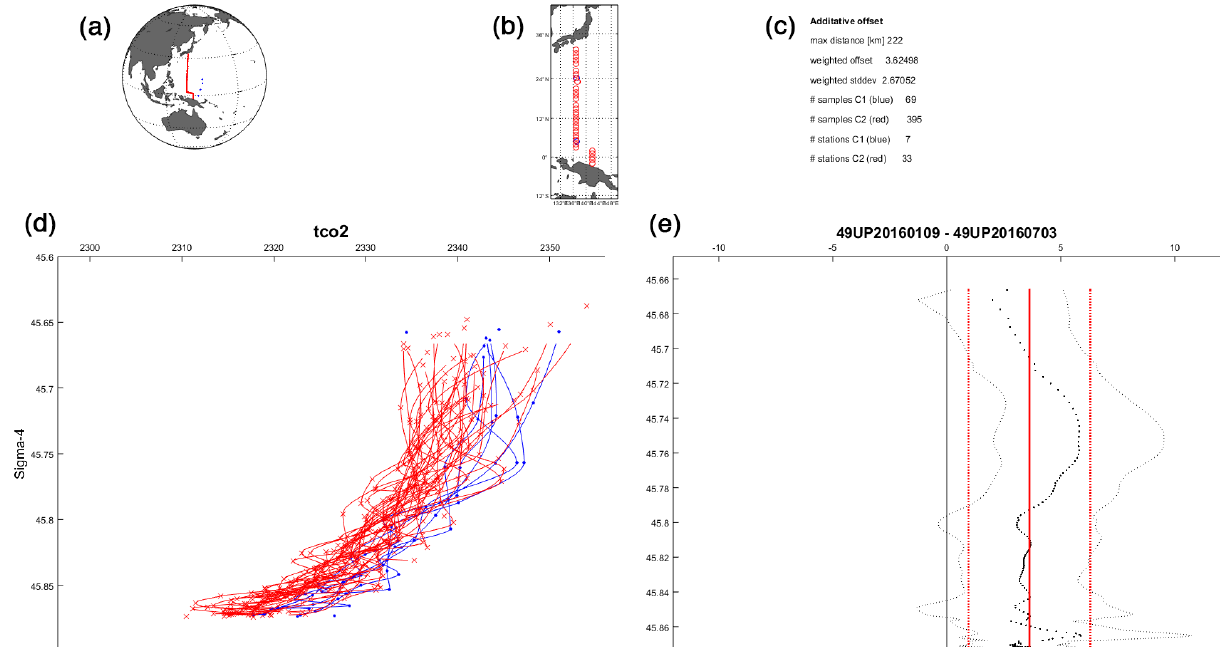
Figure 3. Example crossover figure, for TCO 2 for cruises 49UP20160109 (blue) and 49UP20160703 (red), as it was generated during the crossover analysis. Panel (a) shows all station positions for the two cruises and (b) shows the specific stations used for the crossover analysis. Panel (d) shows the data of TCO 2 (µmolkg − 1 ) below the upper depth limit (in this case 2000dbar) versus potential density anomaly referenced to 4000dbar as points and the interpolated profiles as lines. Non-interpolated data either did not meet minimum depth separation requirements (Table 4 in Key et al., 2010) or are the deepest sampling depth. The interpolation does not extrapolate. Panel (e) shows the mean TCO 2 (µmolkg − 1 ) difference profile (black, dots) with its standard deviation and also the weighted mean offset (straight, red) and weighted standard deviation. Summary statistics are provided in (c)